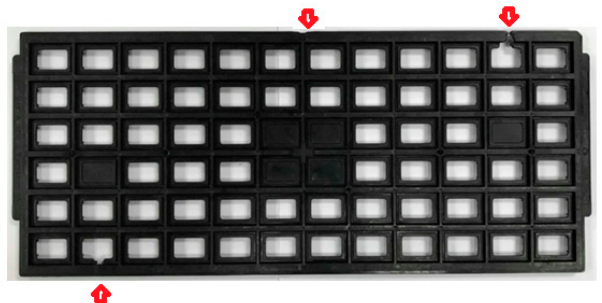
Figure 8. Short shot defects (without packing) for IC trays with under-filling.